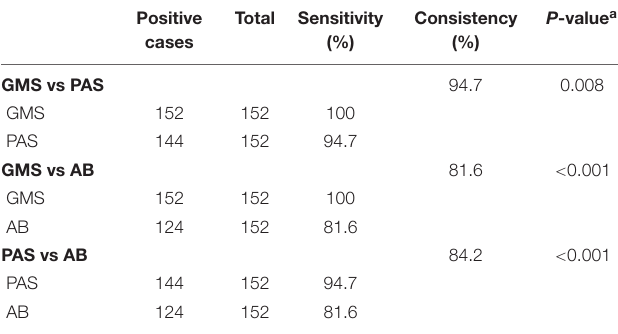
TABLE 2 | Sensitivity values of the three staining methods for pulmonary cryptococcosis. Positive cases